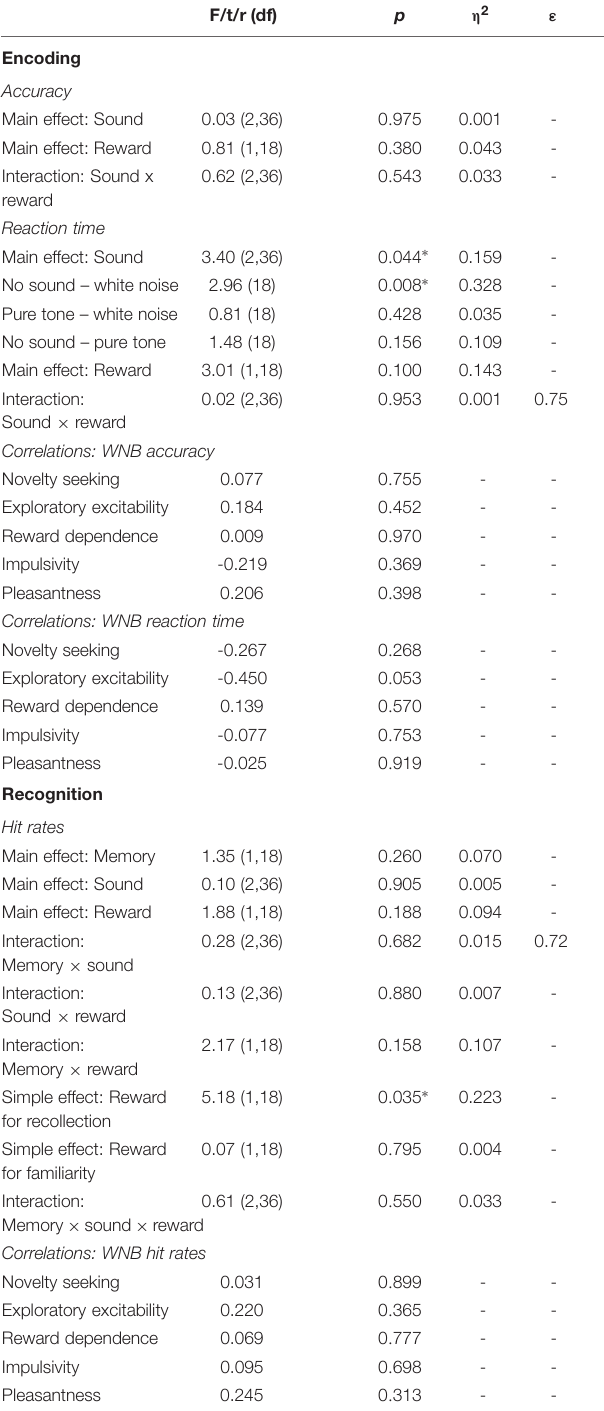
F-values for the ANOVA, t-values for direct comparisons and r-values for correlations are given. p-values a marked with an asterisk whenever they are considered significant. ε -values are given for Greenhouse–Geisser correction. WNB, white noise